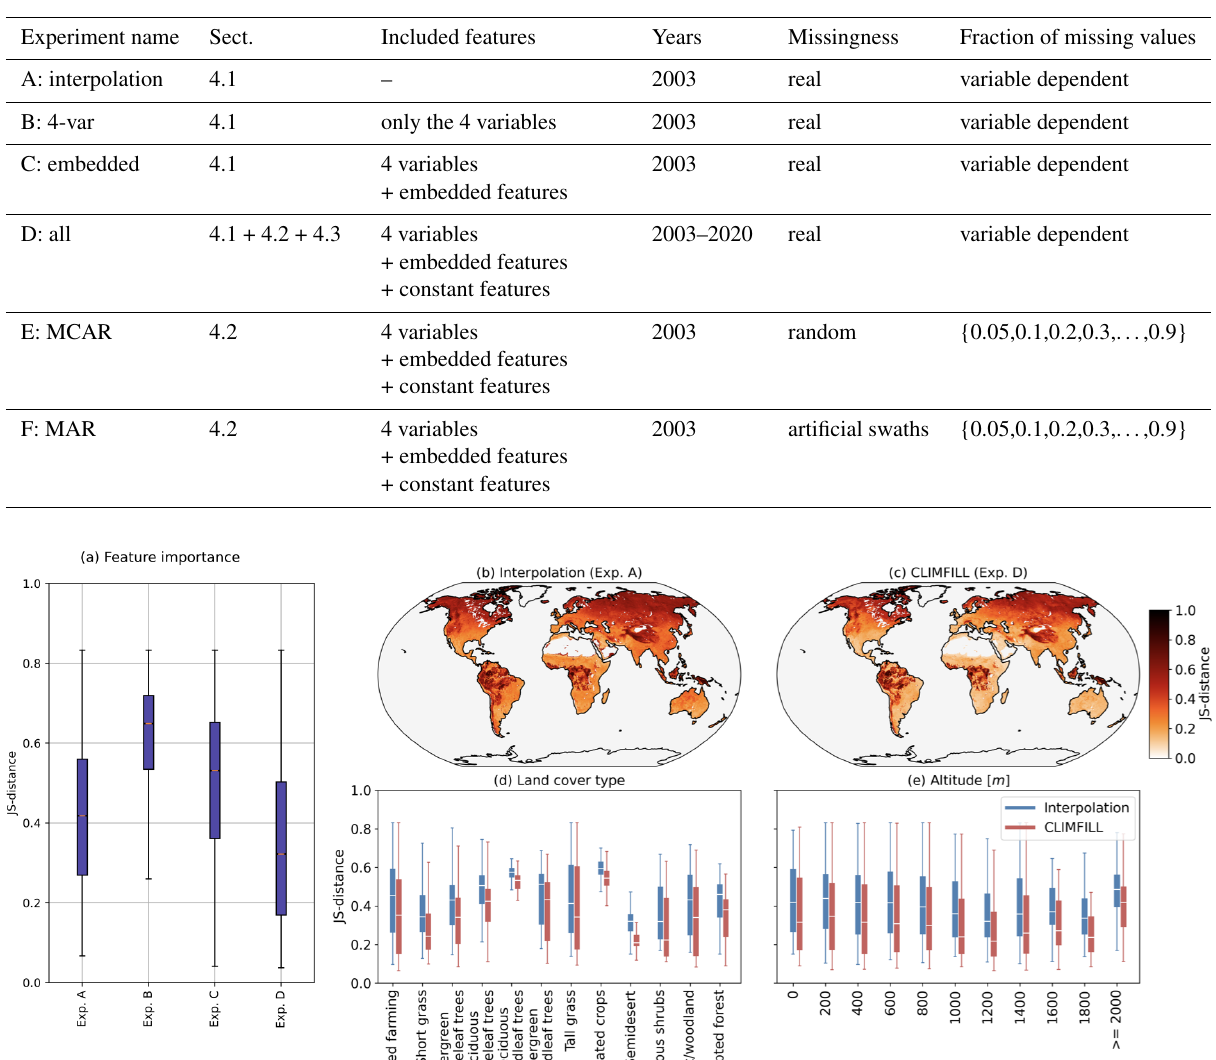
Table 1. Overview of the individual experiments conducted.